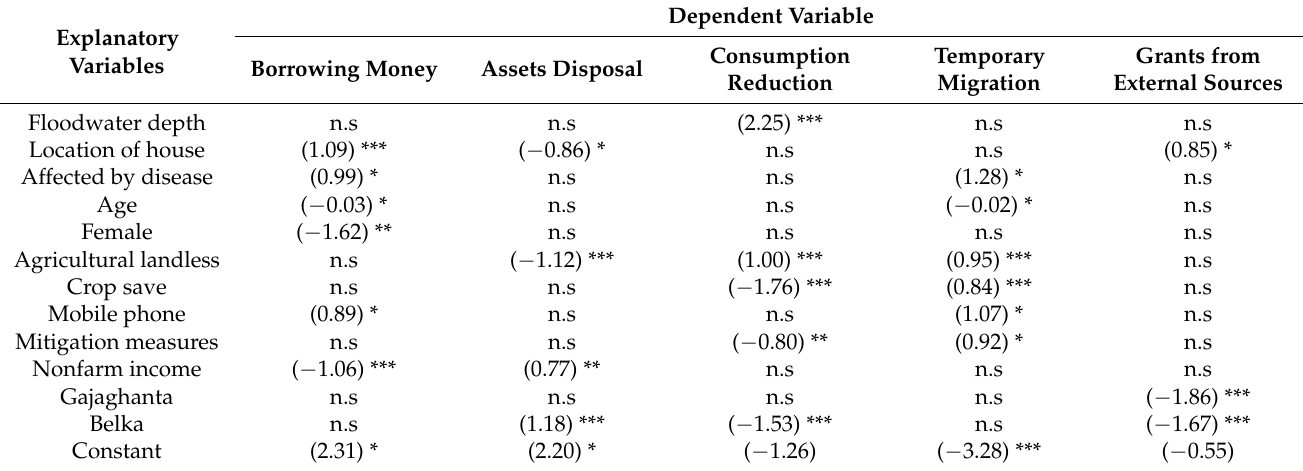
Table 4. Determinants of post-disaster coping